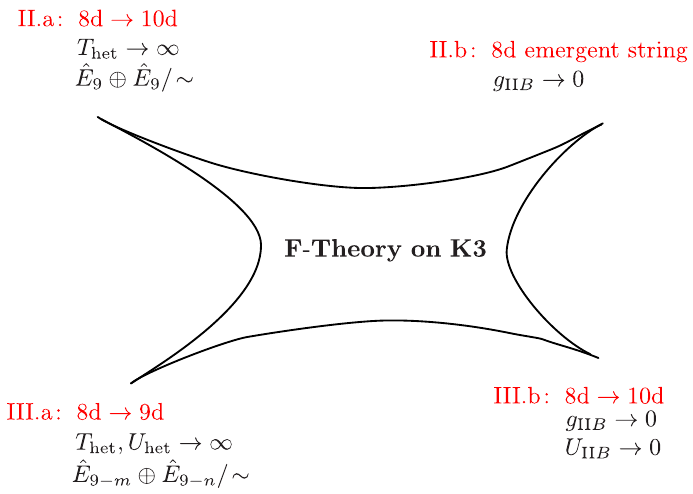
Figure 1 . Infinite distance complex structure degenerations for F-theory on elliptic K3 surface, and the physics in the various asymptotic